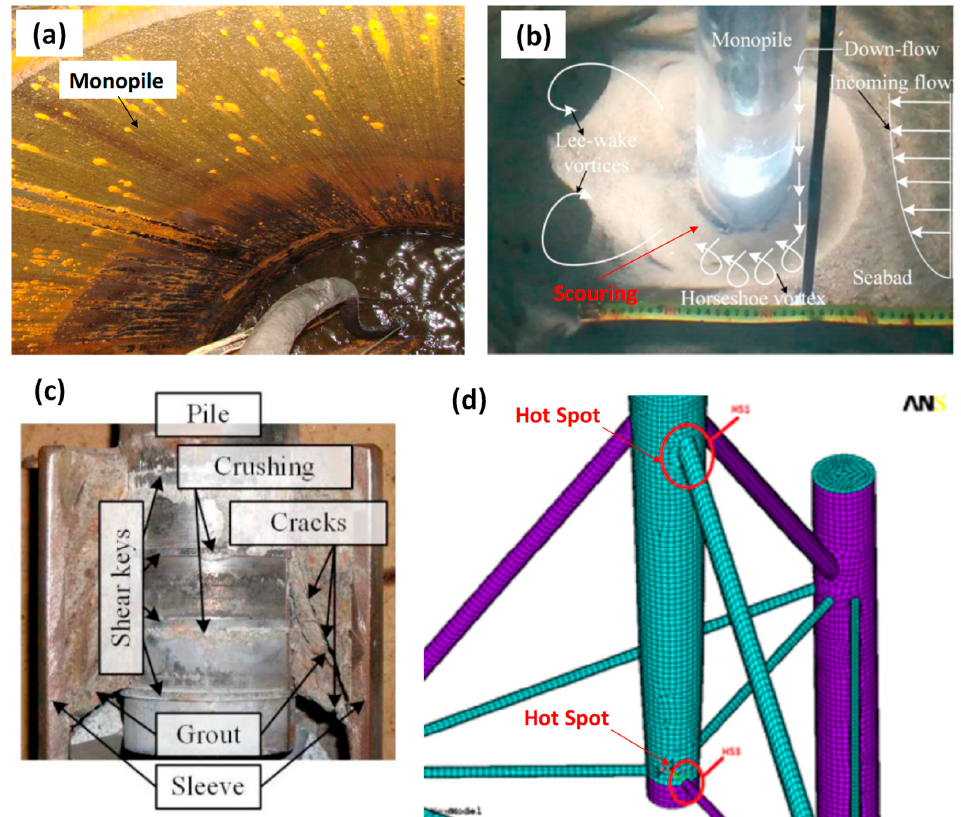
Figure 5. Structural damages in offshore wind turbine substructure and foundation: ( a ) corrosion in the substructure (obtained from [72] ), ( b ) scouring in the sea bed (obtained from [73] ), ( c ) failures of the grouted connection (obtained from [74] ), and ( d ) potential fatigue damage in the joint of the offshore wind turbine tripod (obtained from [75] ).